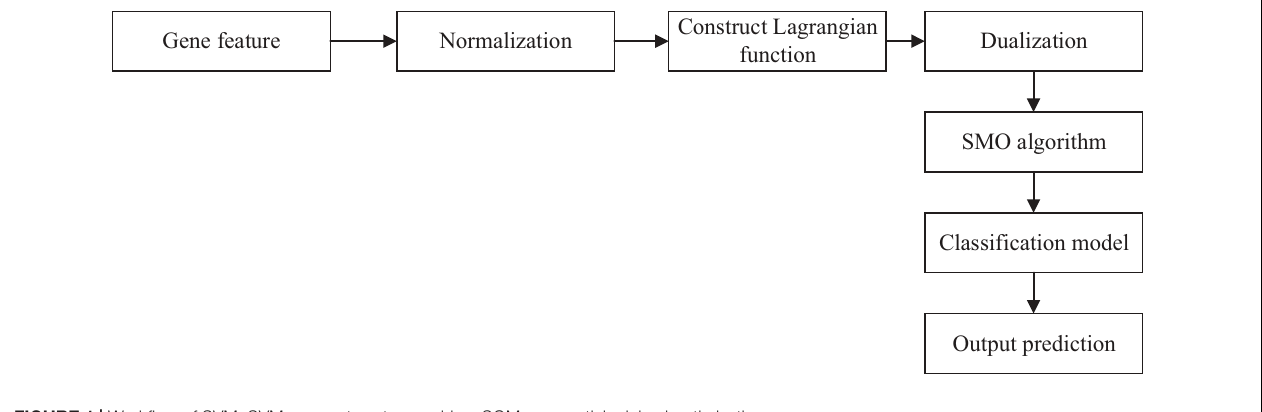
FIGURE 1 | Workflow of SVM. SVM, support vector machine; SOM, sequential minimal optimization.